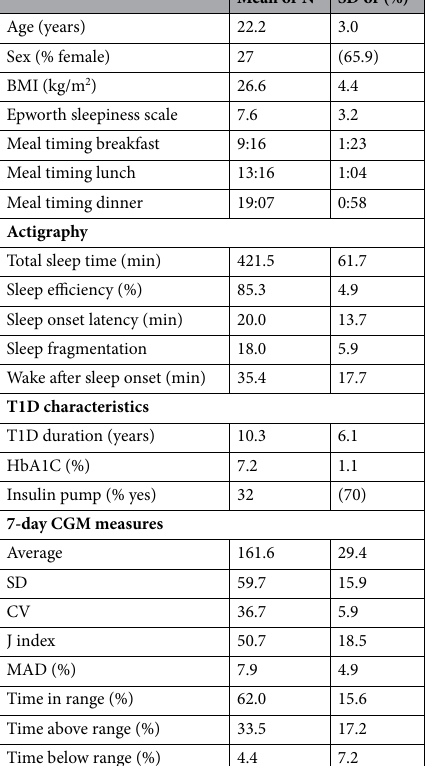
Table 1. Demographic and clinical characteristics (N = 41). BMI body mass index, CGM continuous glucose monitoring, SD standard deviation, CV coefficient of variation, J index overall quality of glucose variability, MAD mean amplitude; time in range (70–180 mg/dL); time above range (> 180 mg/dL); and time below range (< 70